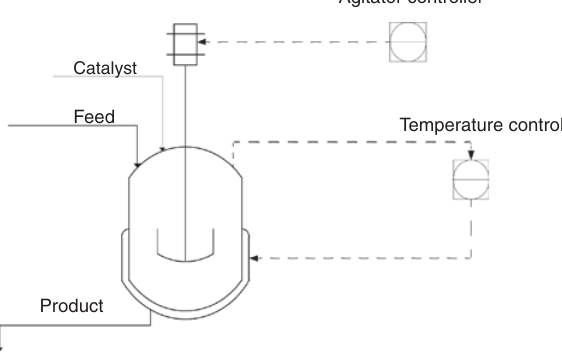
Figure 1: Scheme of the reactor